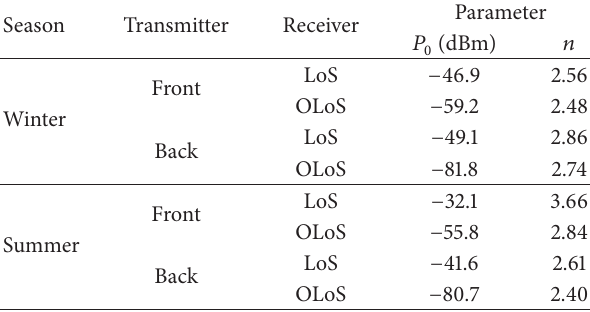
Table 3: Propagation model parameters, deciduous